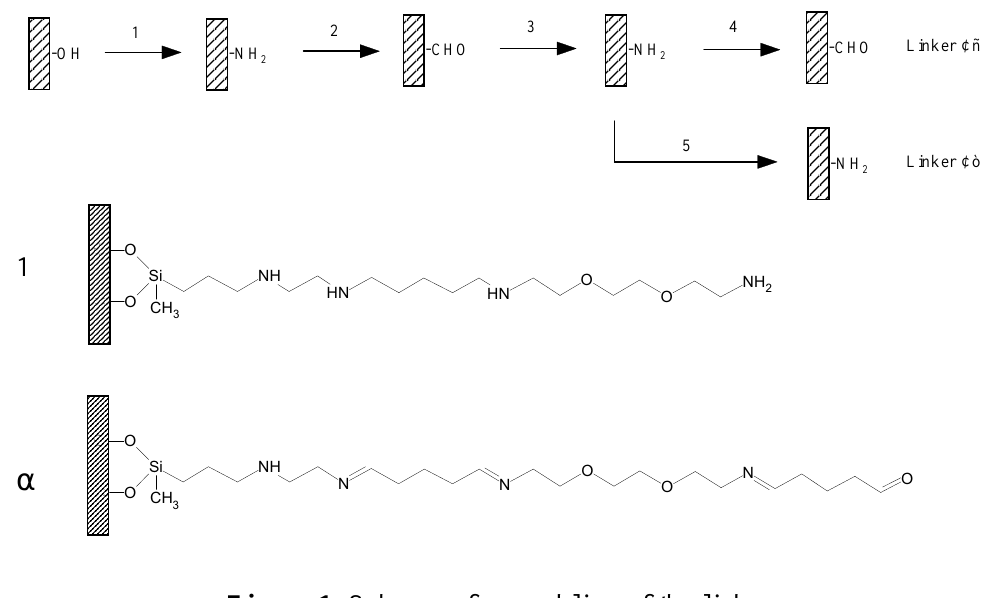
Figure 1. Scheme of assembling of the